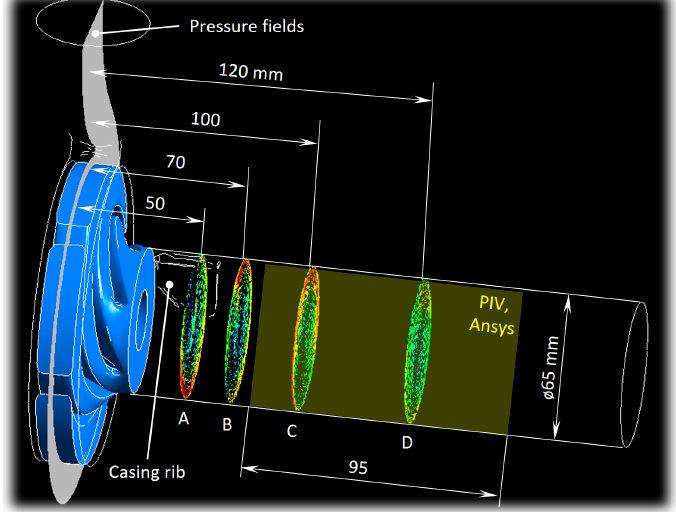
Figure 6. Location of monitored profiles (A, B, C, D—cross-sections depicted in Figure 8).